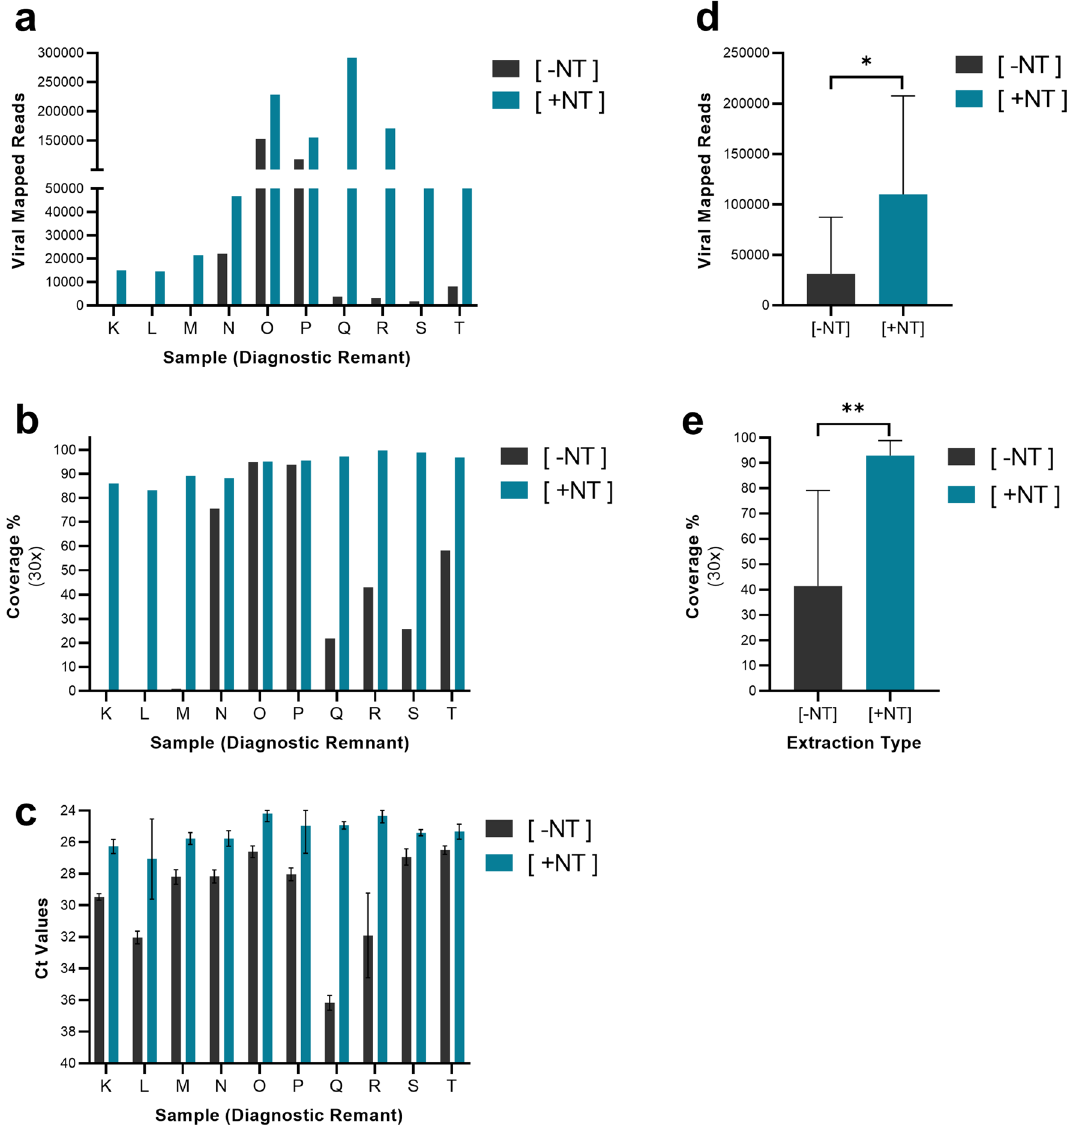
Figure 4. Magnetic Hydrogel Particles (Nanotrap Particle Workflow 3) Improves Sequencing of Diagnostic Remnant SARS-CoV-2 Samples. 10 SARS-CoV-2 positive diagnostic remnant samples were processed using Nanotrap Particle Workflow 3 [+ NT] or the MagMAX kit alone [− NT]. Samples then underwent sequencing on a ONT MinION R.9 flow cell and were analyzed by Viral Mapped Reads to SARS-CoV-2 ( a ), Viral Genome Coverage at 30 × depth ( b ), or RT-PCR ( c ). [+ NT] were compared to [− NT] by paired t -test in order to assess significance of increased viral detection ( d ), ( e ). * p < 0.05, ** p <